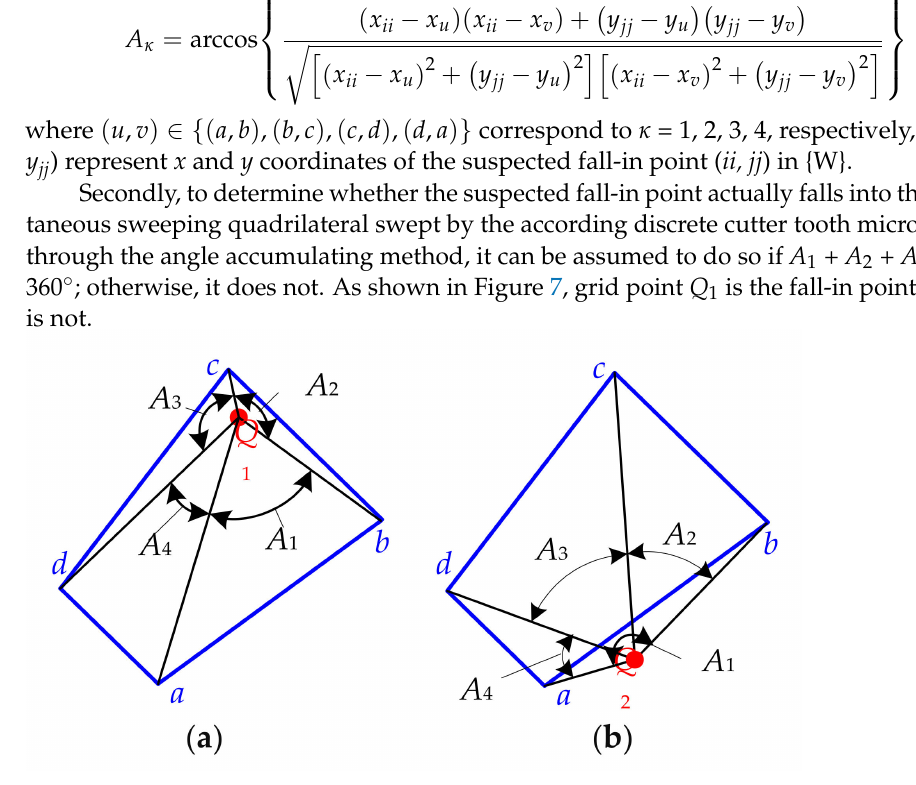
Figure 7. Schematic diagram of angle accumulation. ( a ) Fall-in point and ( b ) Not a fall-in